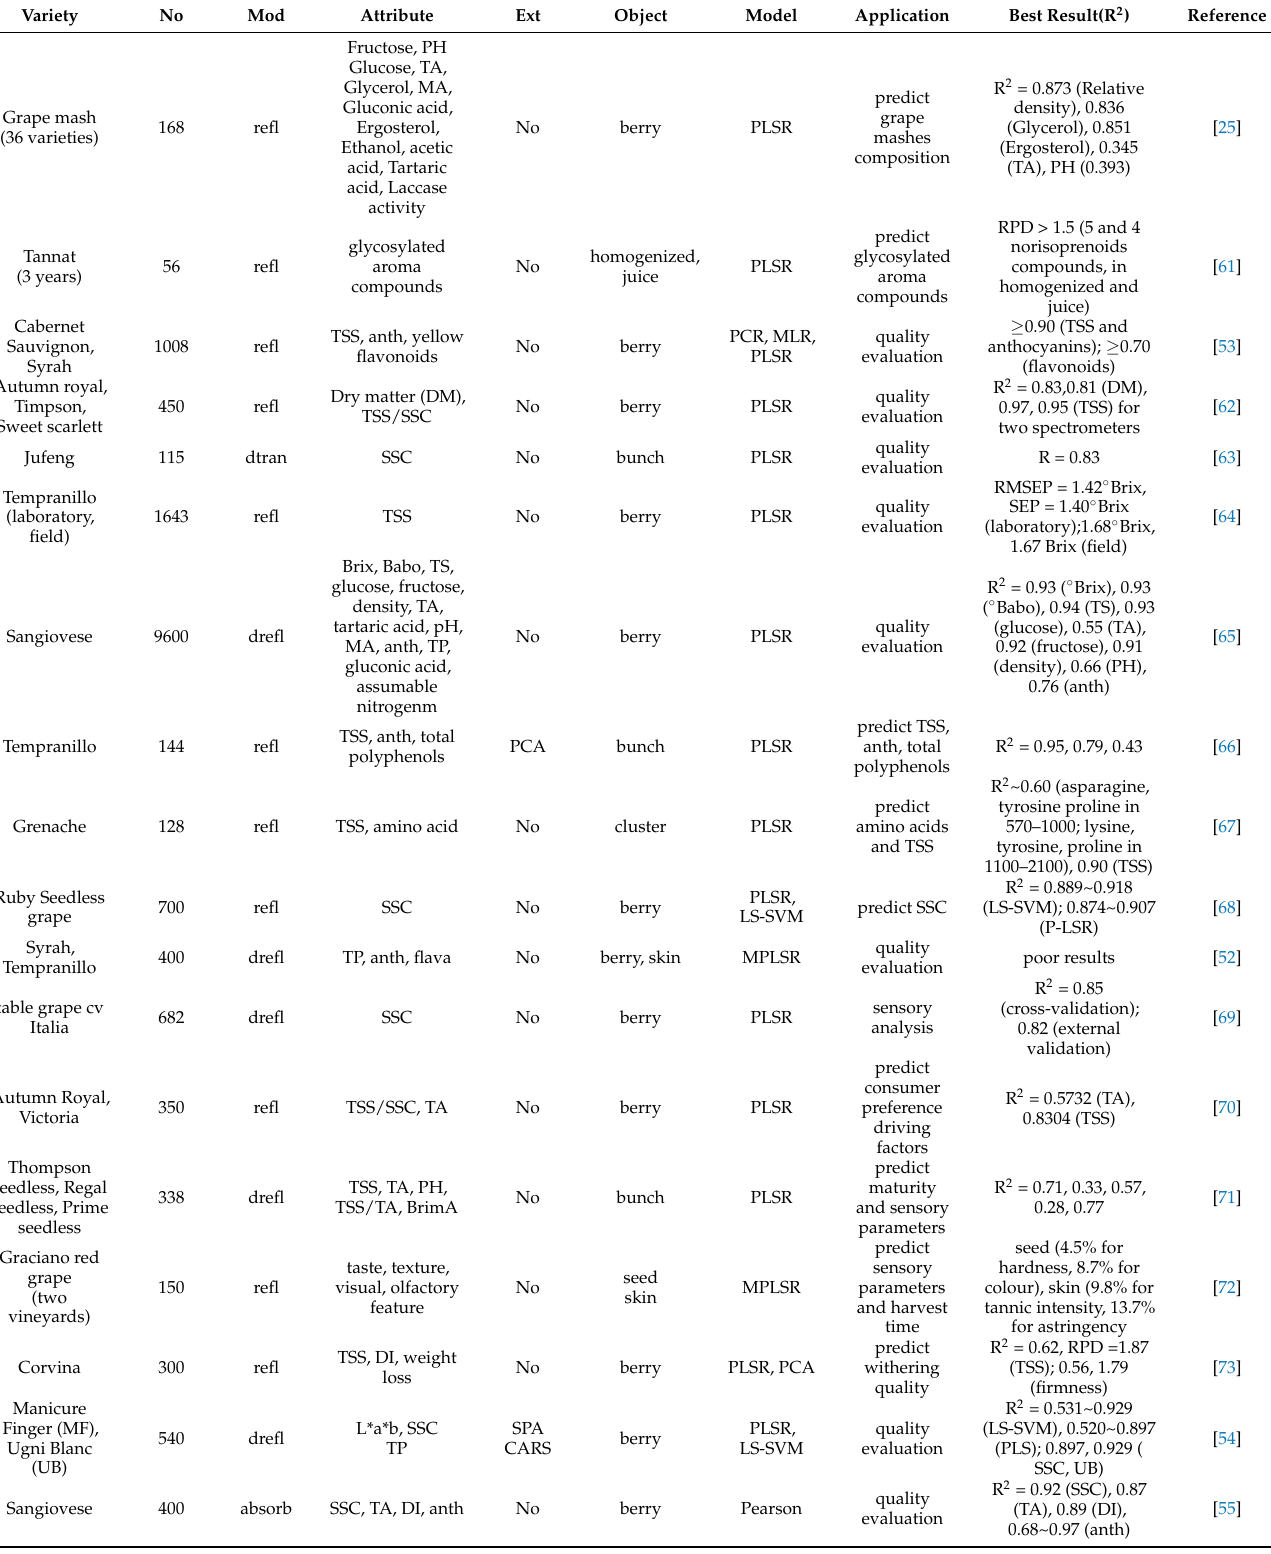
Table 5. Quantitative analysis of near-infrared spectroscopy (NIRS) in grape.